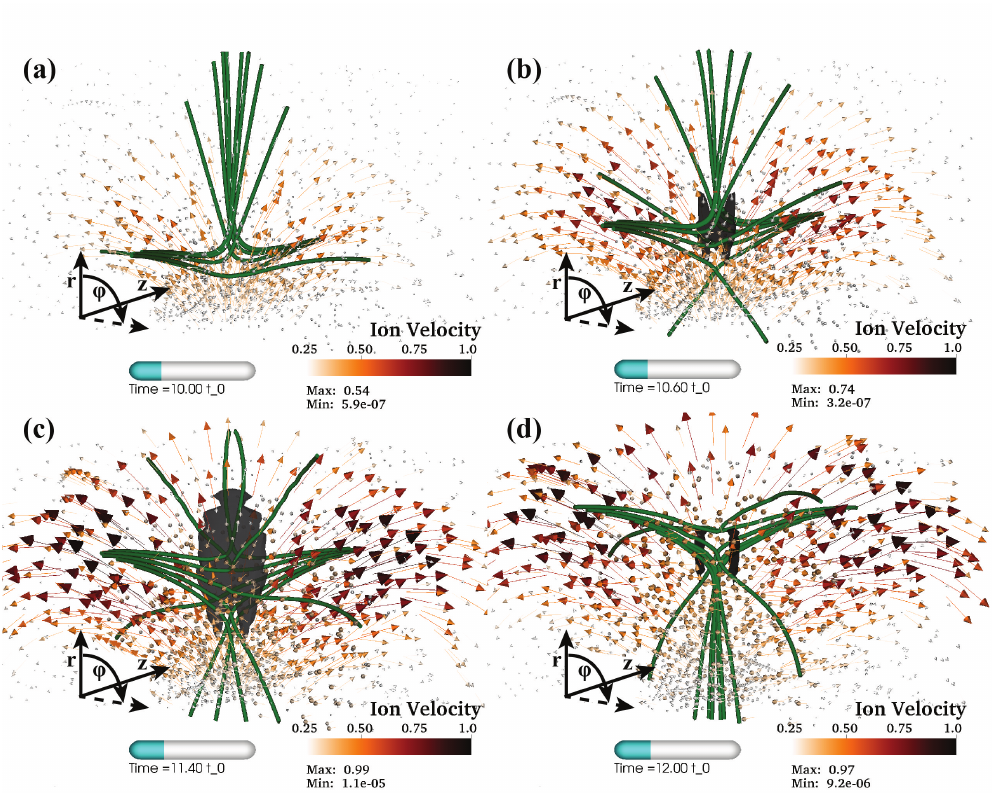
µ e = 5 × 10 − 6 before [panel (a) ], i